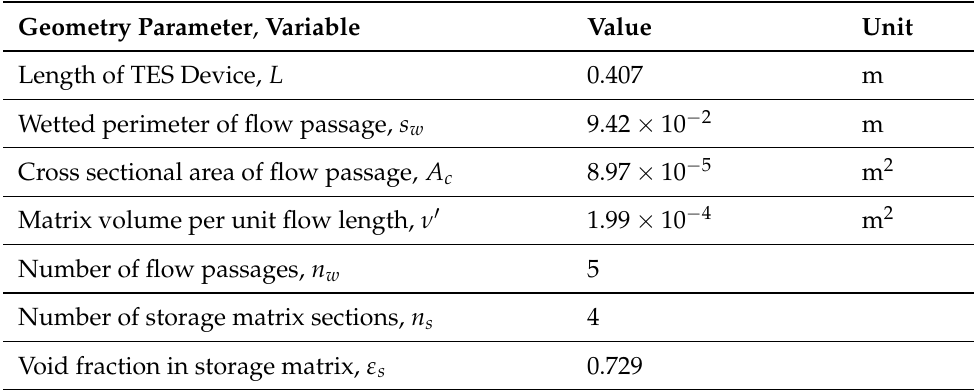
Table 1. Thermal Energy Storage Prototype